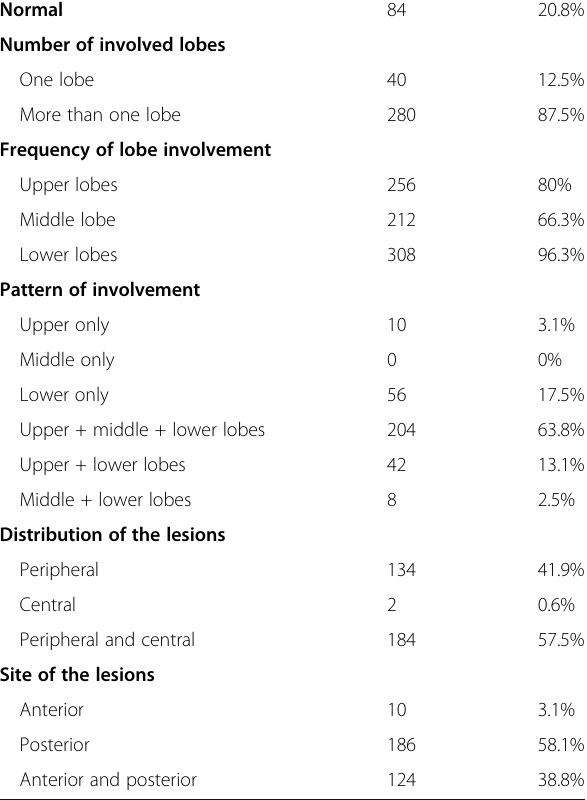
Table 3 Lobar involvement and lesion distribution on chest CT